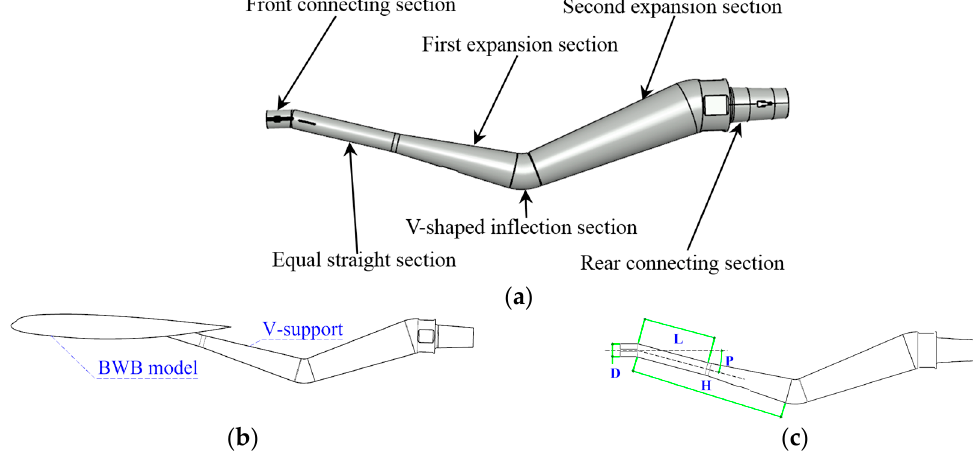
Figure 2. Geometric outline and parameters of the V-shaped support: ( a ) di ff erent sections of the V-shaped support; ( b ) outline of a BWB model with the V-shaped support; ( c ) geometric parameters of the V-shaped support.